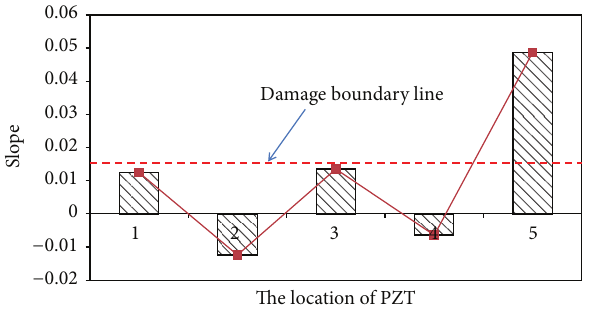
Figure 19: A damage metric chart of RMSD’s slope for damage.